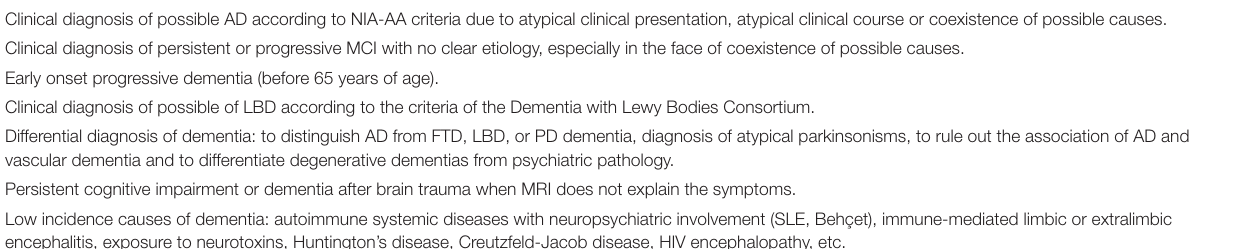
TABLE 2 | Clinical situations in which perfusion SPECT or FDG PET can be useful. Clinical diagnosis of possible AD according to NIA-AA criteria due to atypical clinical presentation, atypical clinical course or coexistence of possible causes. Clinical diagnosis of persistent or progressive MCI with no clear etiology, especially in the face of coexistence of possible causes. Early onset progressive dementia (before 65 years of age). Clinical diagnosis of possible of LBD according to the criteria of the Dementia with Lewy Bodies Consortium. Differential diagnosis of dementia: to distinguish AD from FTD, LBD, or PD dementia, diagnosis of atypical parkinsonisms, to rule out the association of AD and vascular dementia and to differentiate degenerative dementias from psychiatric pathology. Persistent cognitive impairment or dementia after brain trauma when MRI does not explain the symptoms.